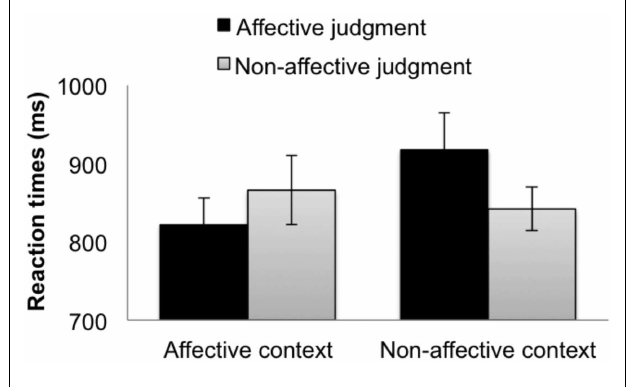
FIGURE 3 | RTs for the (word) targets when participants made affective judgments (black bars) and non-affective judgments (gray bars) in the affective context group (left bars) and the non-affective context group (right bars). The error bars indicate subject-wise